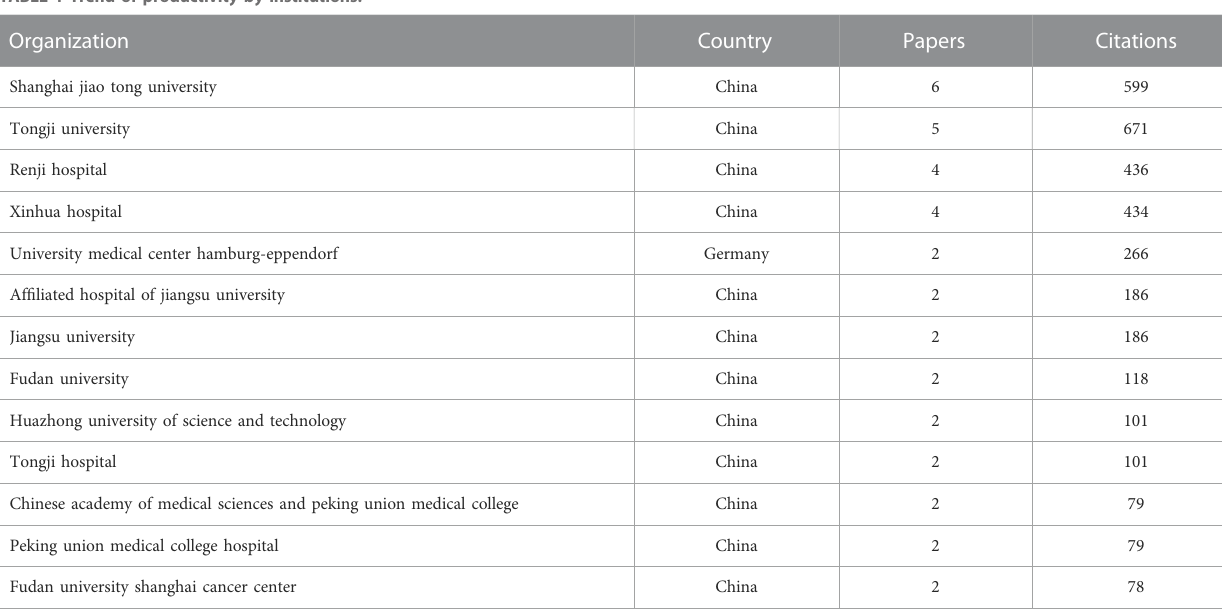
TABLE 1 Trend of productivity by institutions. Organization Country